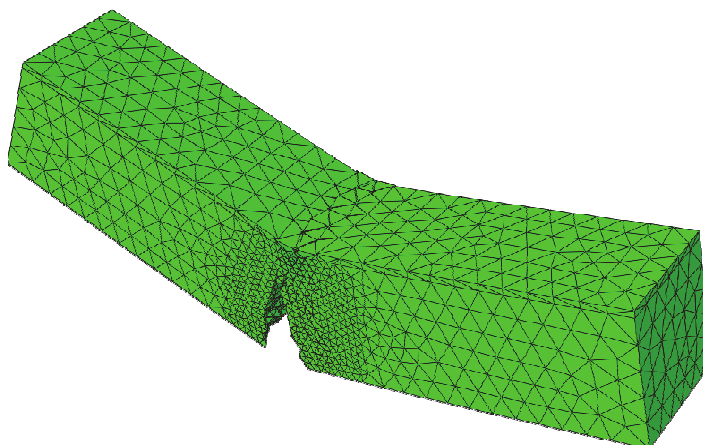
Figure 9: Simulation of the fiber reinforced concrete specimen failure in 4-point bend test.